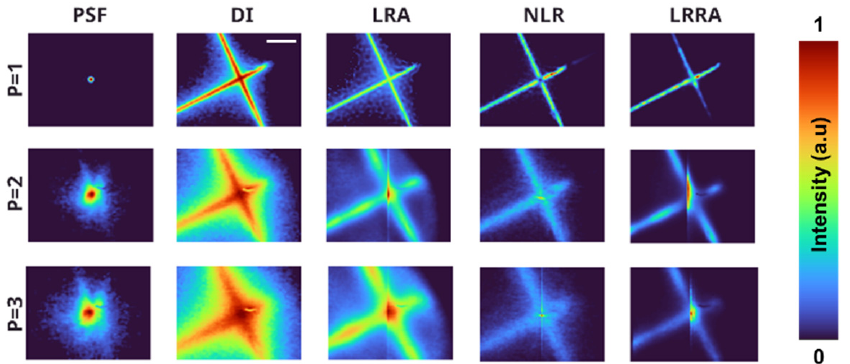
Figure 7. Images of the PSF, DI of the test object—1, reconstruction results using LRA, NLR and LRRA. The scale bar has a length of 1 mm.